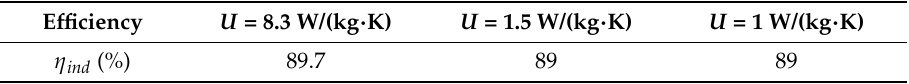
Table 7. Efficiency system for the first configuration varying the transmittance of the tank.